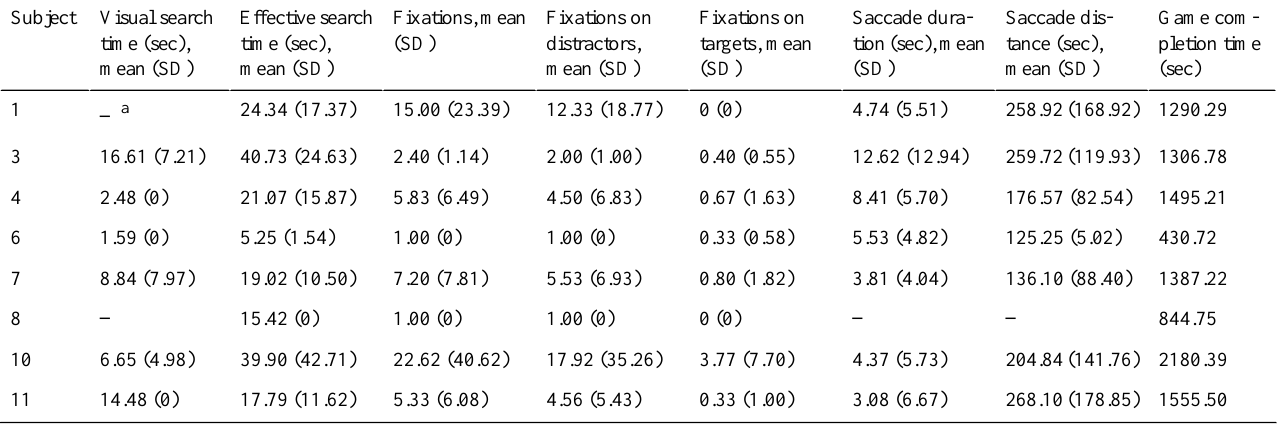
Table 2. Eye movement metrics and game performance of participants (n=8).